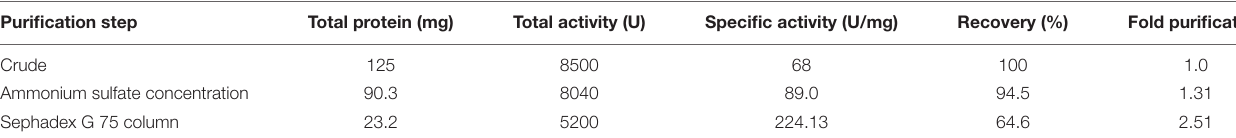
TABLE 1 | Purification of the keratinolytic protease from Thermoactinomyces sp. strain RM4.